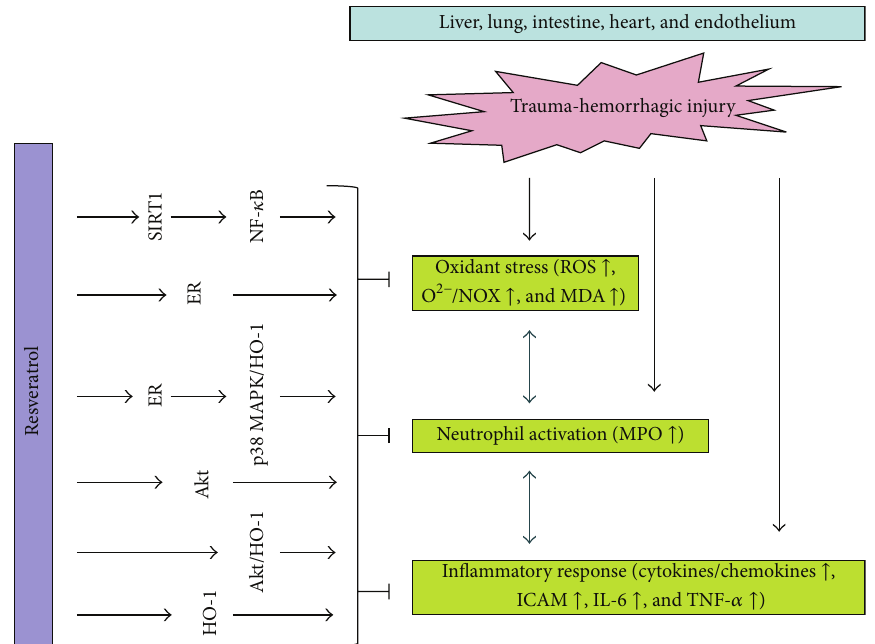
Figure 1: The anti-inflammatory and protective pathways of resveratrol in trauma-hemorrhagic injury. ER: estrogen receptor; SIRT1: sirtuin 1; HO-1: hemeoxygenase-1; p38 MAPK: p38 mitogen-activated protein kinase; NF- 𝜅 B: nuclear factor-kappa B; ROS: reactive oxygen species; MDA: malondialdehyde; NOX: NADPH oxidase; MPO: myeloperoxidase; ICAM: intercellular adhesion molecule; IL-6: interleukin